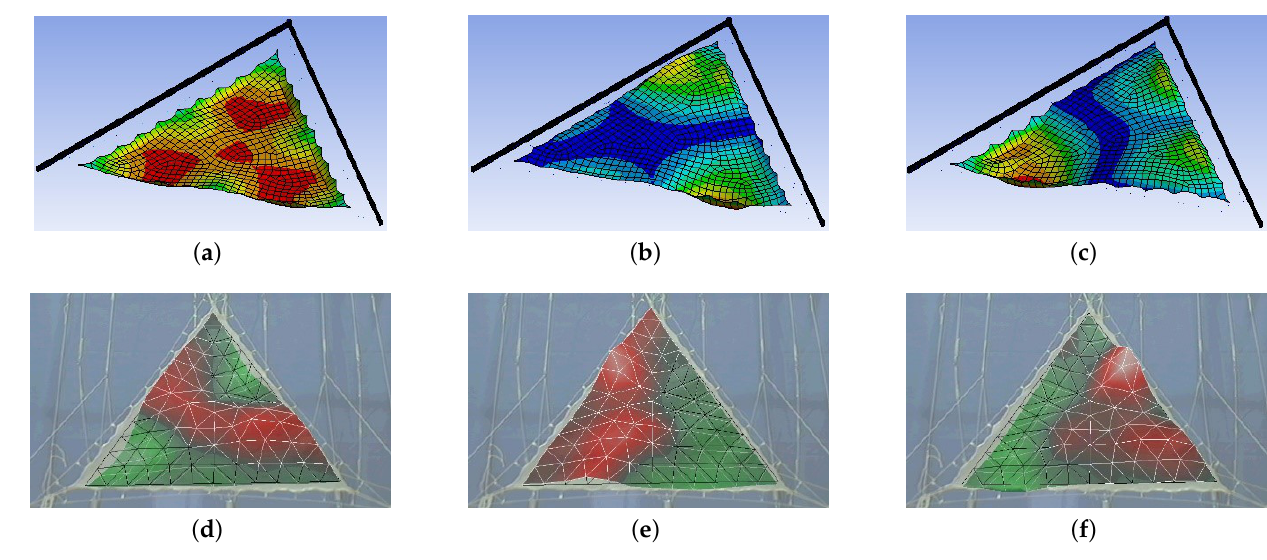
Figure 9. Comparison between test and simulation mode shapes: ( a ) 1st simulation mode, ( b ) 2nd simulation mode, ( c ) 3rd simulation mode, ( d ) 1st test mode, ( e ) 2nd test mode and ( f ) 3rd test mode.